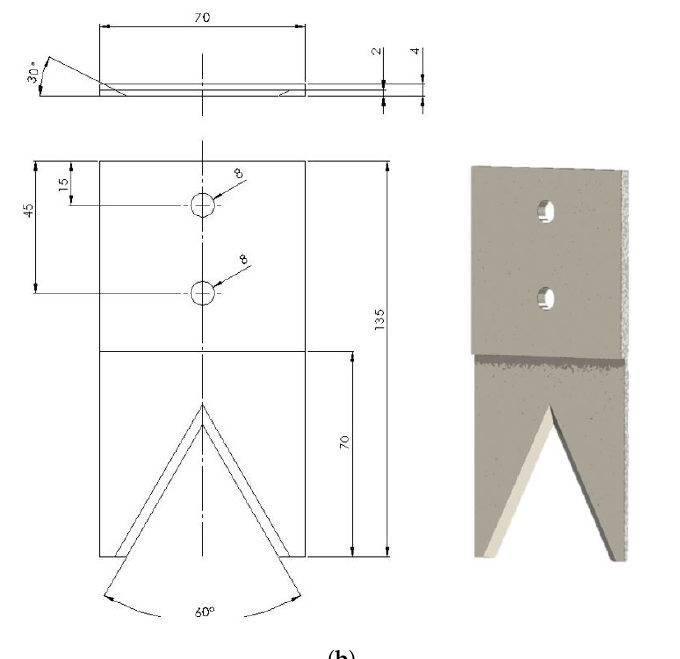
Figure 4. ( a ) Modified Warner–Bratzler straight blade. ( b ) Modified Warner–Bratzler V-notched blade. All dimensions are in